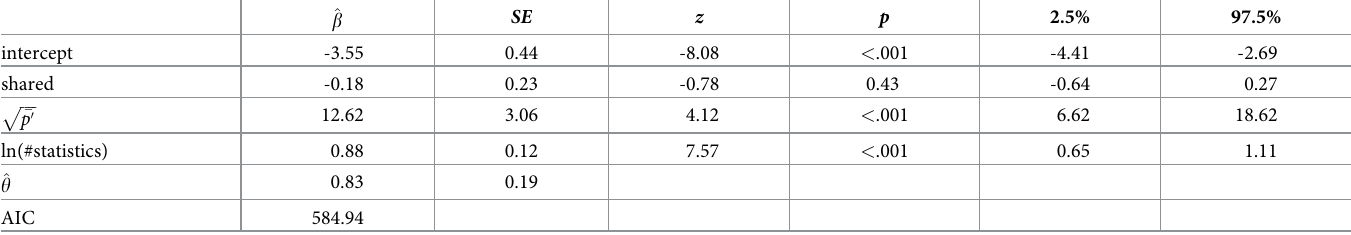
Table 6. Replication of the relationship between data sharing and consistency